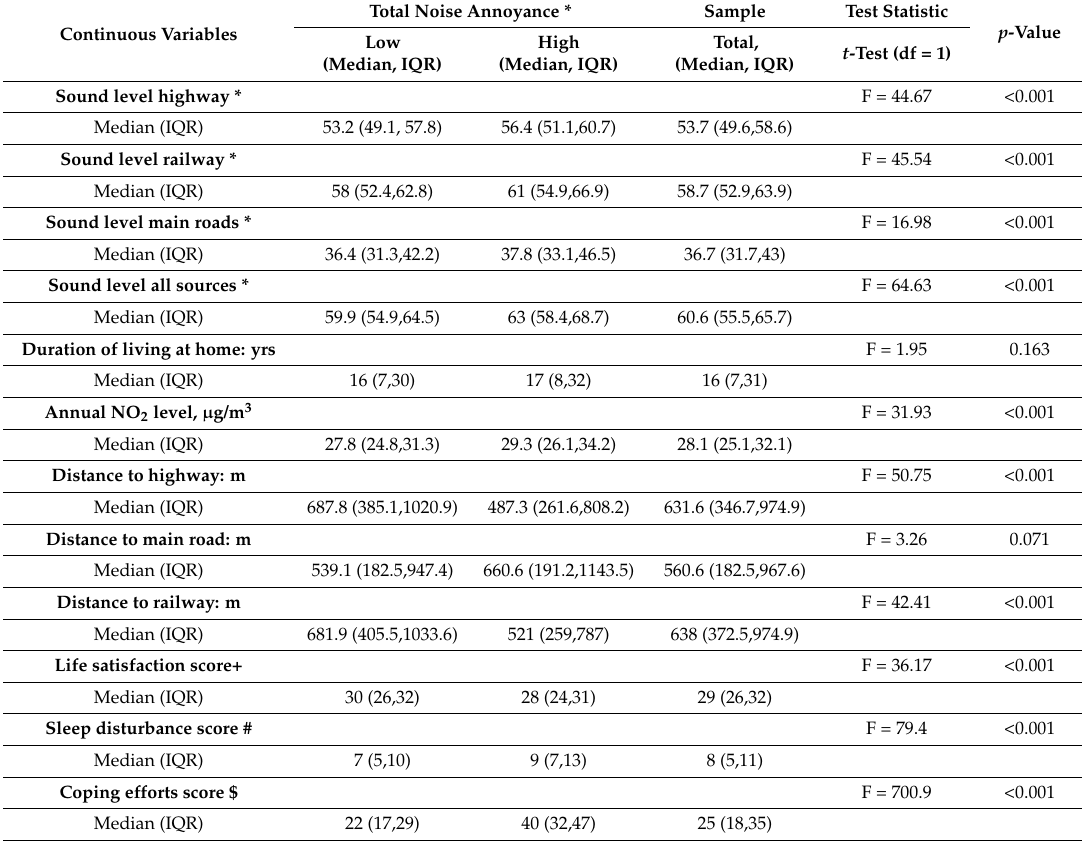
Table 2. Statistical description of continuous variables in the various models broken down by total highly